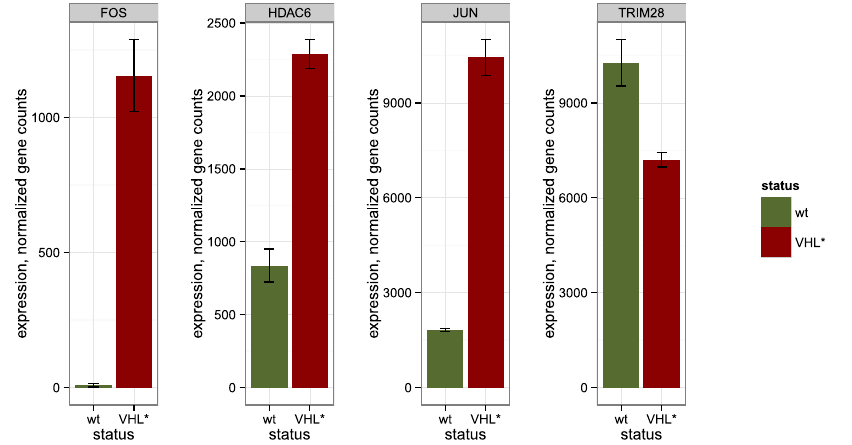
Figure 5. Gene expression in wild type Caki-1 and Caki-1 VHL * cells for certain genes either involved in regulation of DNA methylation or having their binding sites enriched with hypomethylated or hypermethylated